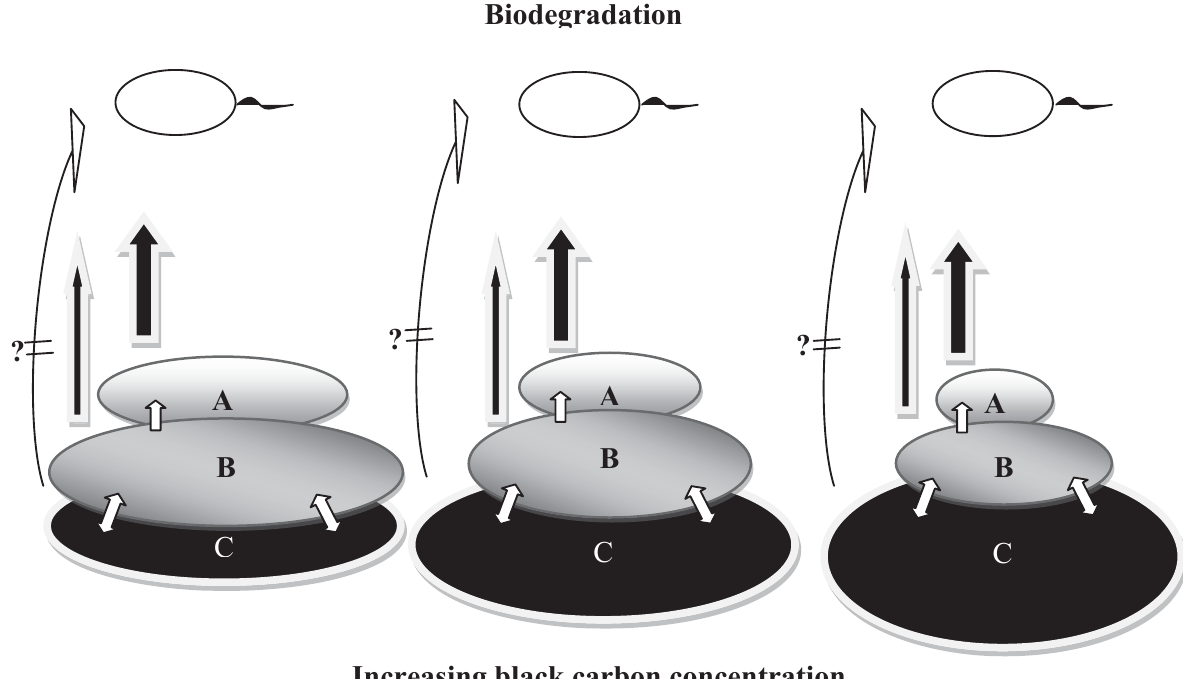
Figure 4. Diagram showing organic chemical flux arising from ( A ) bioavailable, ( B